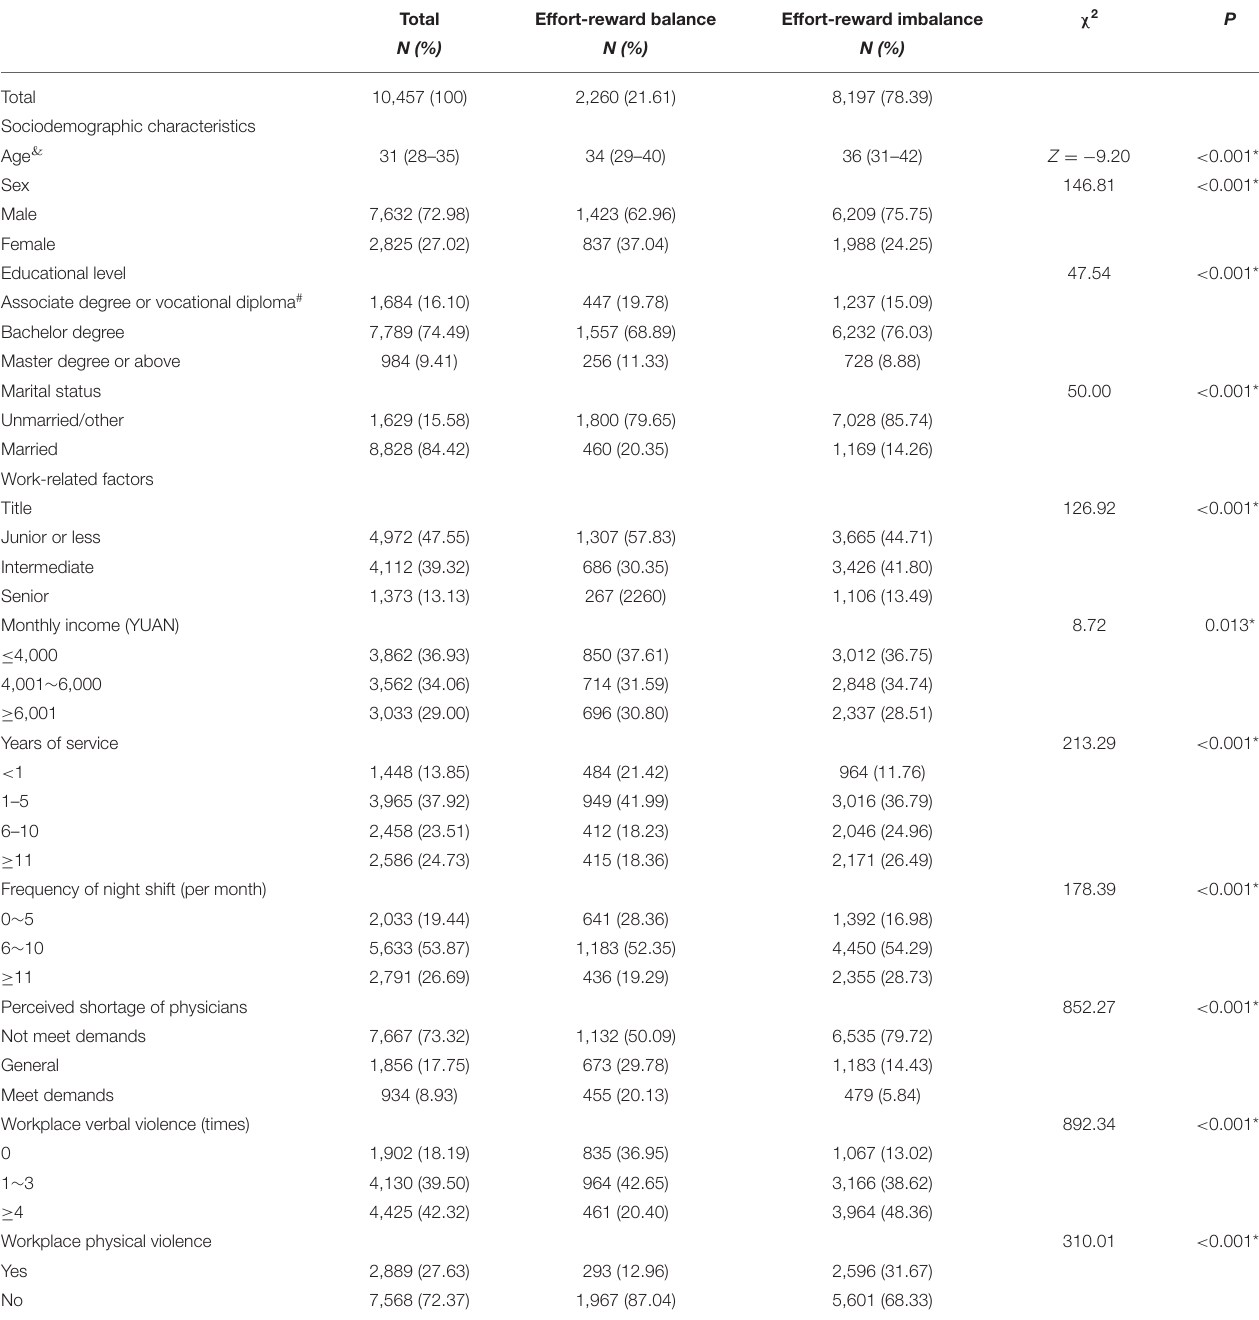
TABLE 1 | Comparisons of characteristics in different effort-reward status groups among physicians in the emergency department. Total Effort-reward balance Effort-reward